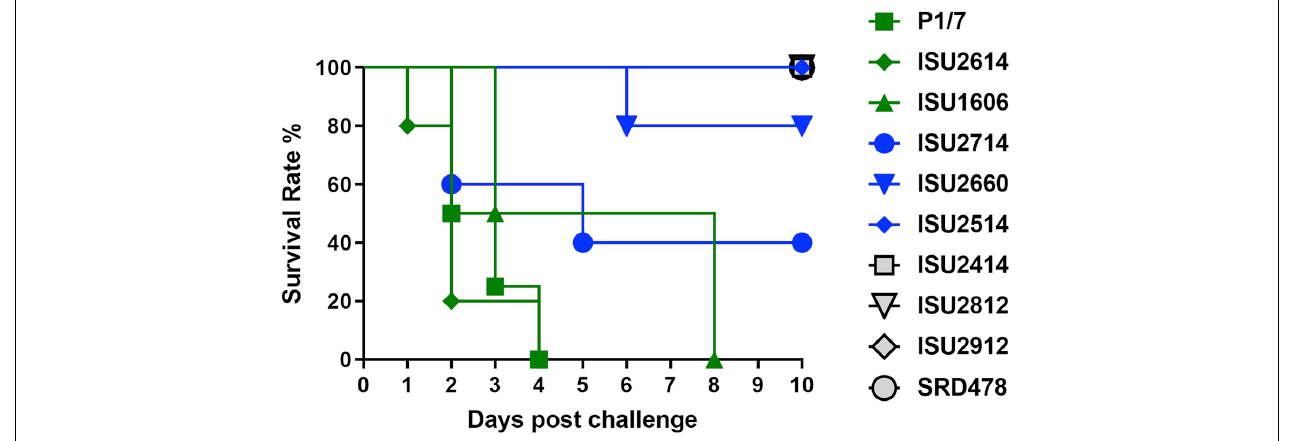
FIGURE 1 | Survival rates of pigs post intranasal challenge. On day 0 groups of 4-5, 8-week-old CDCD pigs were intranasally inoculated with 2 mL (1 mL per nostril) of approximately 1 × 10 9 CFU/mL of each S. suis isolate. The x -axis indicates days post-challenge, and the y -axis indicates percent